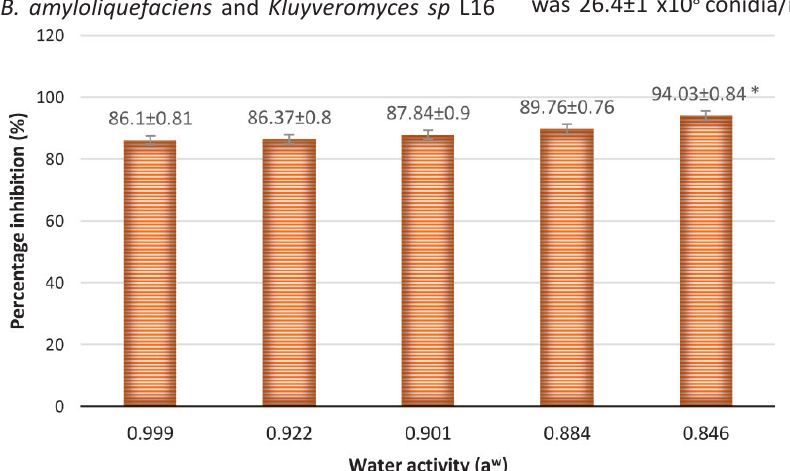
Fig. 12. Percentage inhibition of A. flavus at different water activities showing an increasing trend in inhibitions as water activity decreased. Inhibition percentage = (Radius of Control- Radius of Test/ Radius of Control) x100. Values are represented as Mean ± SD (n=3). *Value is statistically significant at P ≤ 0.05 in t-test